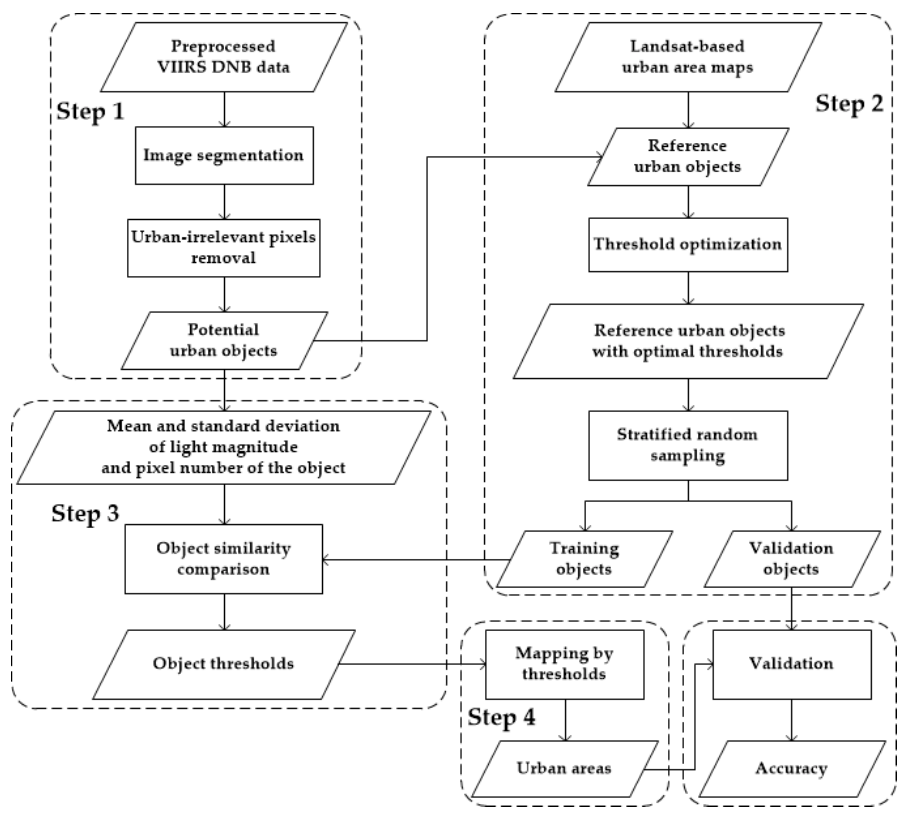
Figure 3. Framework of the object similarity-based thresholding method.